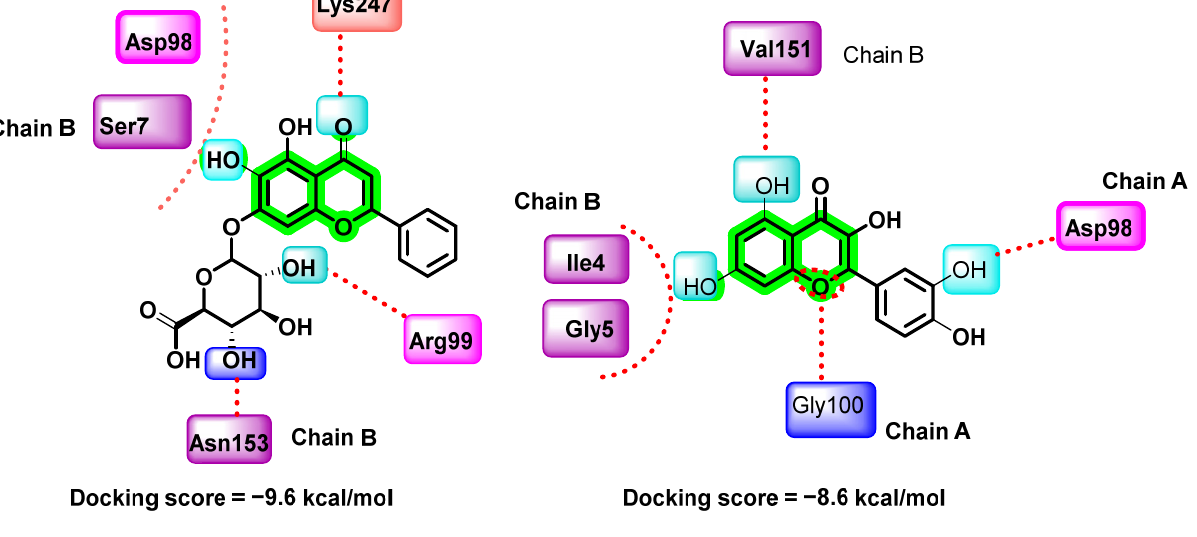
Figure 14. Hydrogen bonding interactions of baicalin and quercetin complex with DENV-2 My.